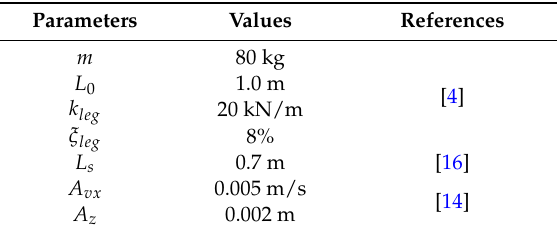
Table 1. Parameters of the crowd.